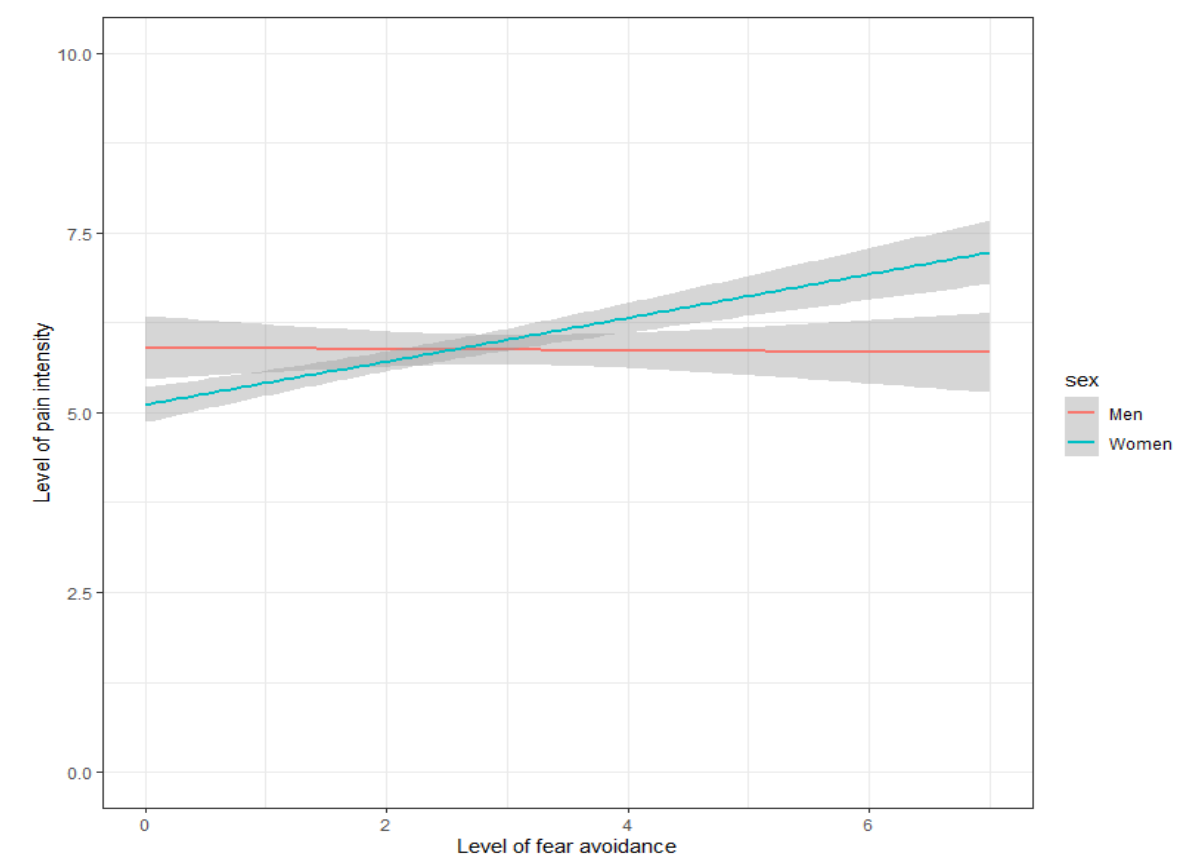
Figure 3. Visualization of the interaction between fear-avoidance and sex in relation to pain intensity. Note: the grey area is the 95% confidence interval of the estimates.